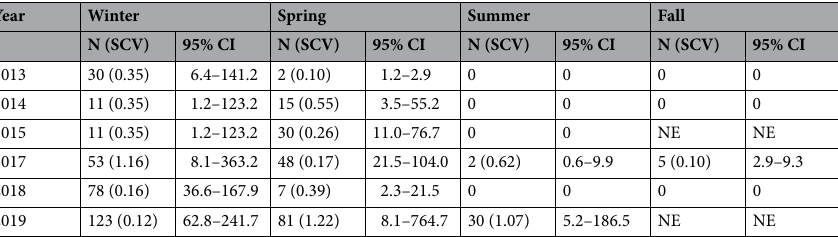
Table 2. Right whale seasonal abundance estimates (N), squared coefficients of variation (SCV), and 95% upper and lower confidence limits (95% CI). NE = no survey effort.